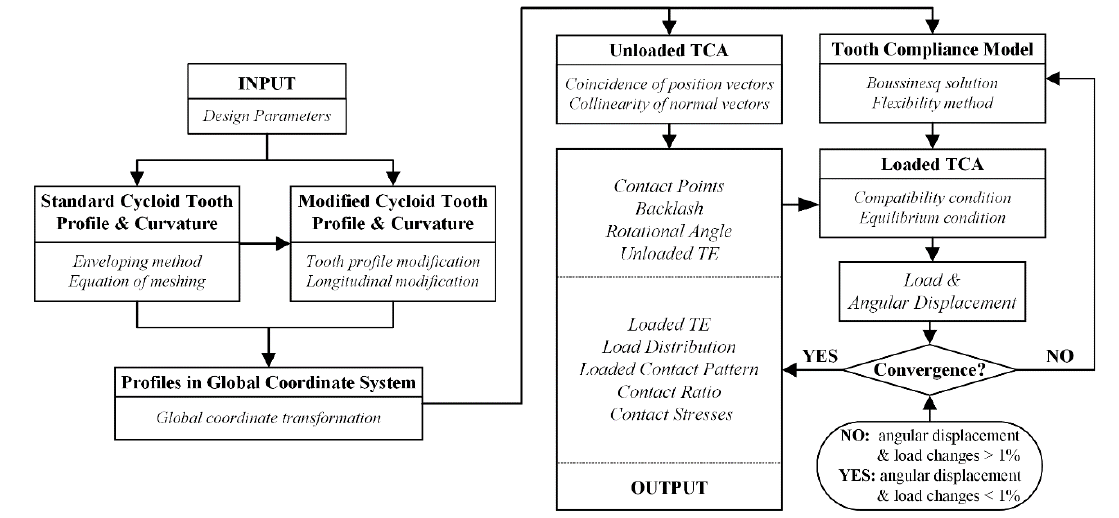
Figure 5. A flowchart of the load distribution analysis methodology for cycloid drives.